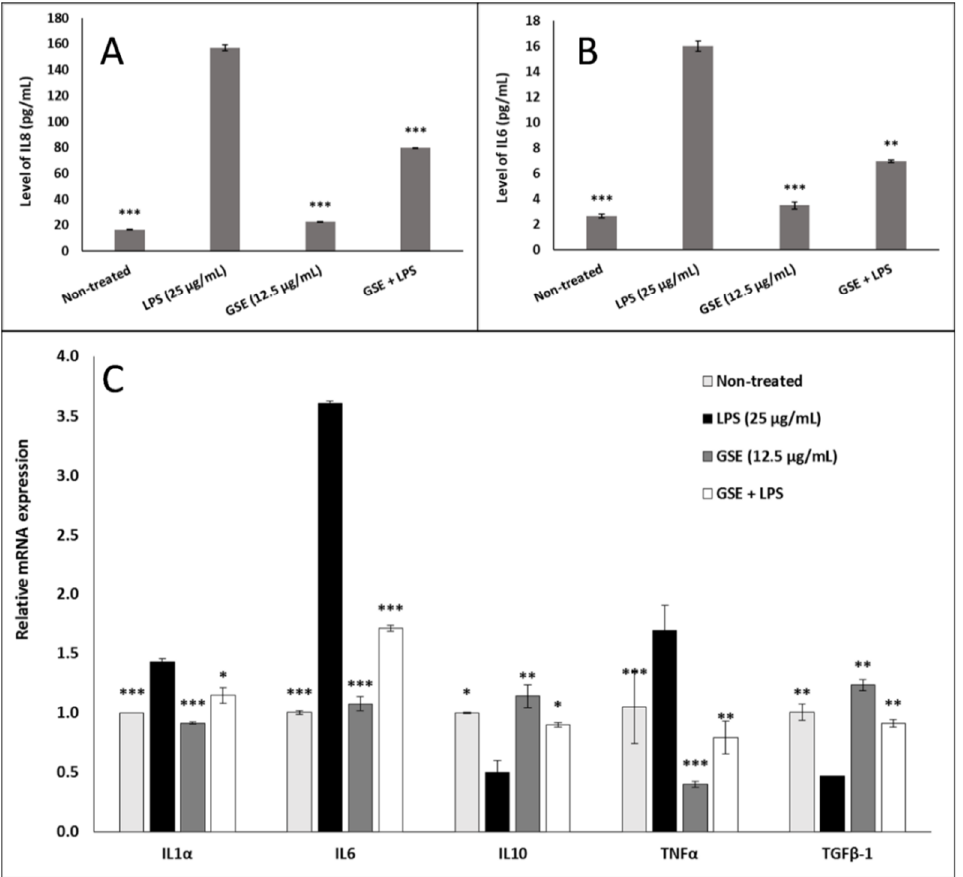
Figure 6. Effect of GSE on pro- and anti-inflammatory cytokines in Caco-2 cells treated with LPS, GSE, or LPS + GSE for 24 h. ( A ) Interleukin 8 (IL8) protein expression in culture medium was significantly elevated in LPS-treated cells compared to untreated control. GSE treatment alone did not significantly alter expression compared to untreated control but GSE significantly attenuated the LPS-induced increase in IL8 expression. ( B ) Interleukin 6 (IL6) protein expression in culture medium showed the same pattern as IL8. ( C ) Relative gene expression of pro-inflammatory cytokines IL1α, IL6, and tumor necrosis factor alpha (TNFα) showed a similar attenuation of LPS-induced expression upon GSE treatment. Relative gene expression of anti-inflammatory cytokines interleukin 10 (IL10) and transforming growth factor beta-1 (TGFβ-1) showed a significant decrease in LPS-treated cells compared to untreated control which was attenuated by cotreatment with GSE. Error bars indicate ± S.D. ( n = 3). *, **, and *** indicate the data were significantly different relative to LPS-treated positive control with p ≤ 0.05, p ≤ 0.01, and p ≤ 0.001 respectively using Tukey’s test.